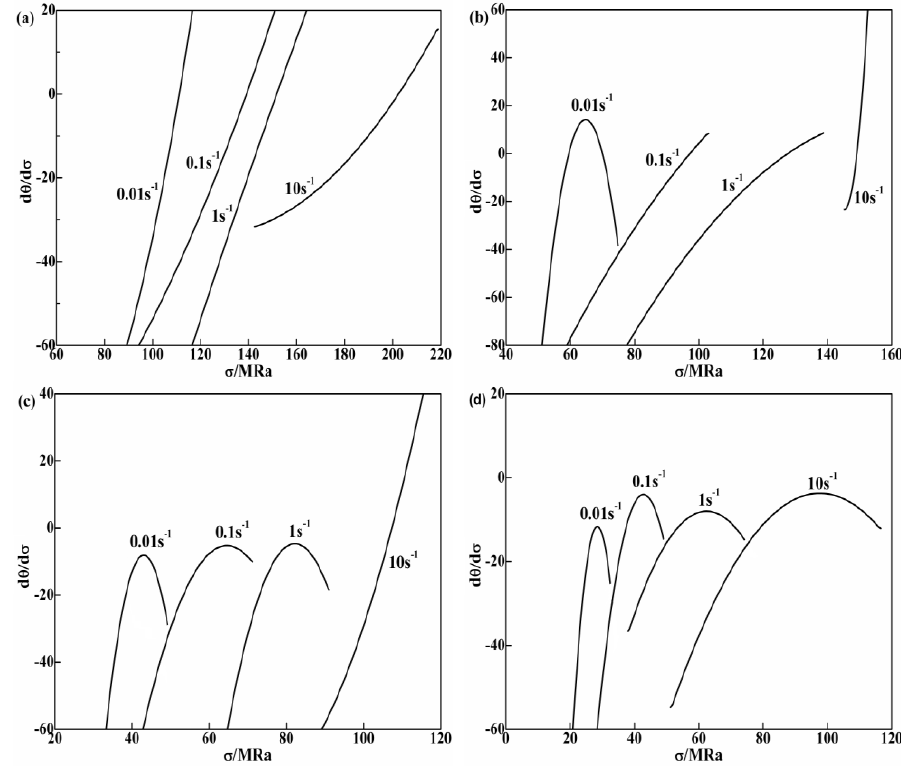
Figure 9. Curves of dθ/dσ versus σ for 35CrMo steel under different deformation temperatures: ( a )